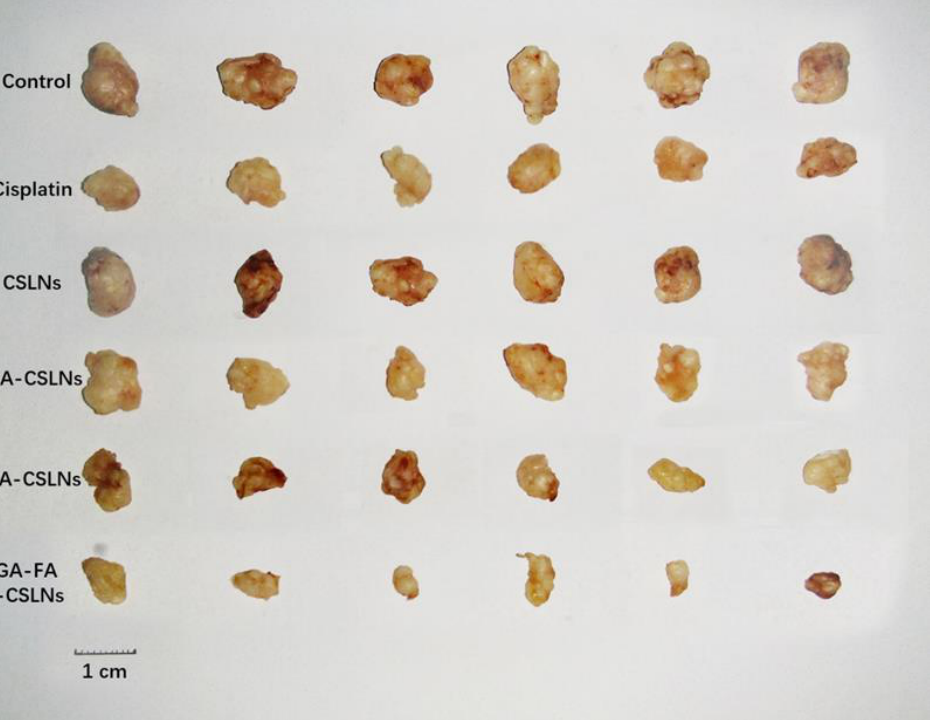
Figure 14. CSLNs modified with different ligands on tumor-bearing nude mice after dissection of tumor ( n = 6).